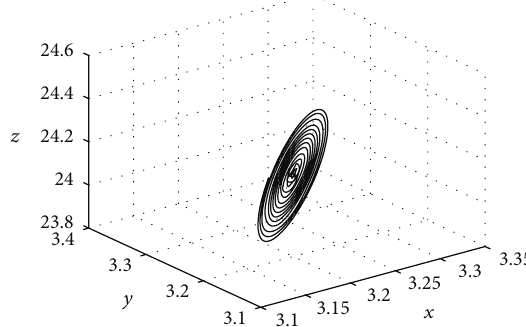
Figure 8: A Hopf bifurcation occurs at the steady state 𝑆 + of system (4) when 𝑏 1 = 𝑏 𝑐